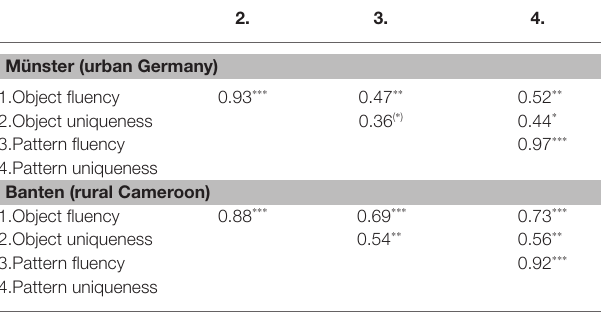
TABLE 2 | Correlations between the different scores.